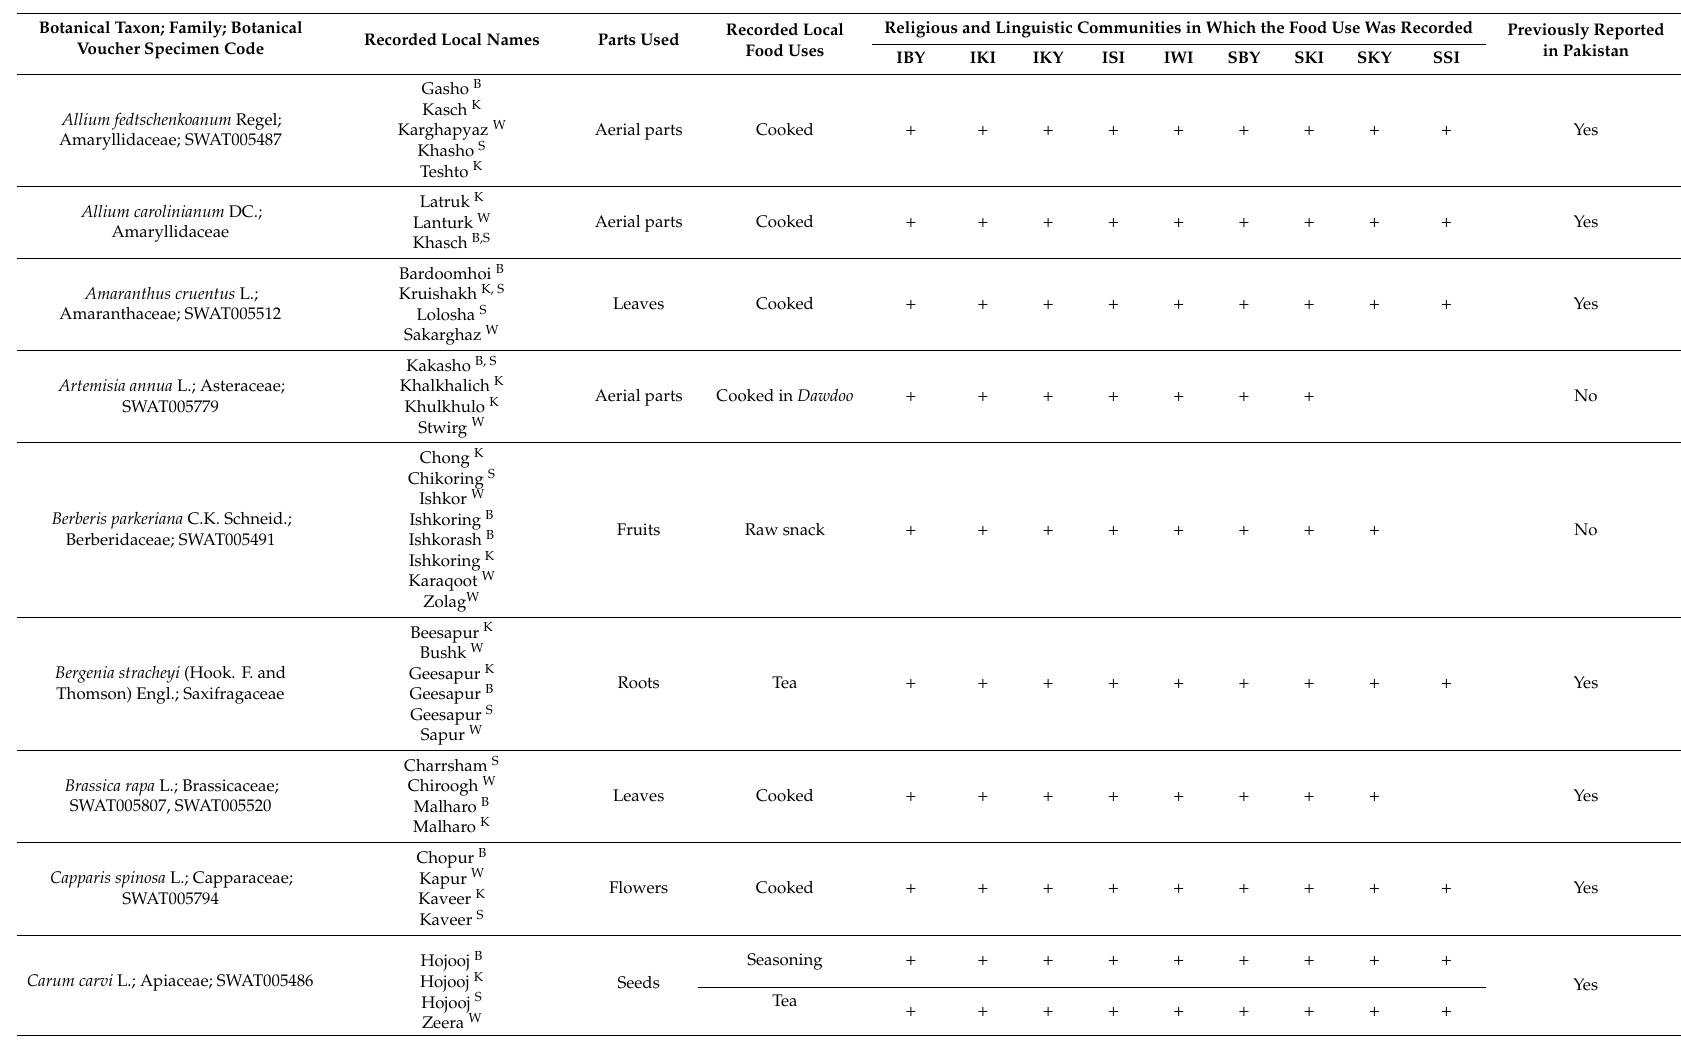
Table 2. Gathered wild food plants recorded in the study